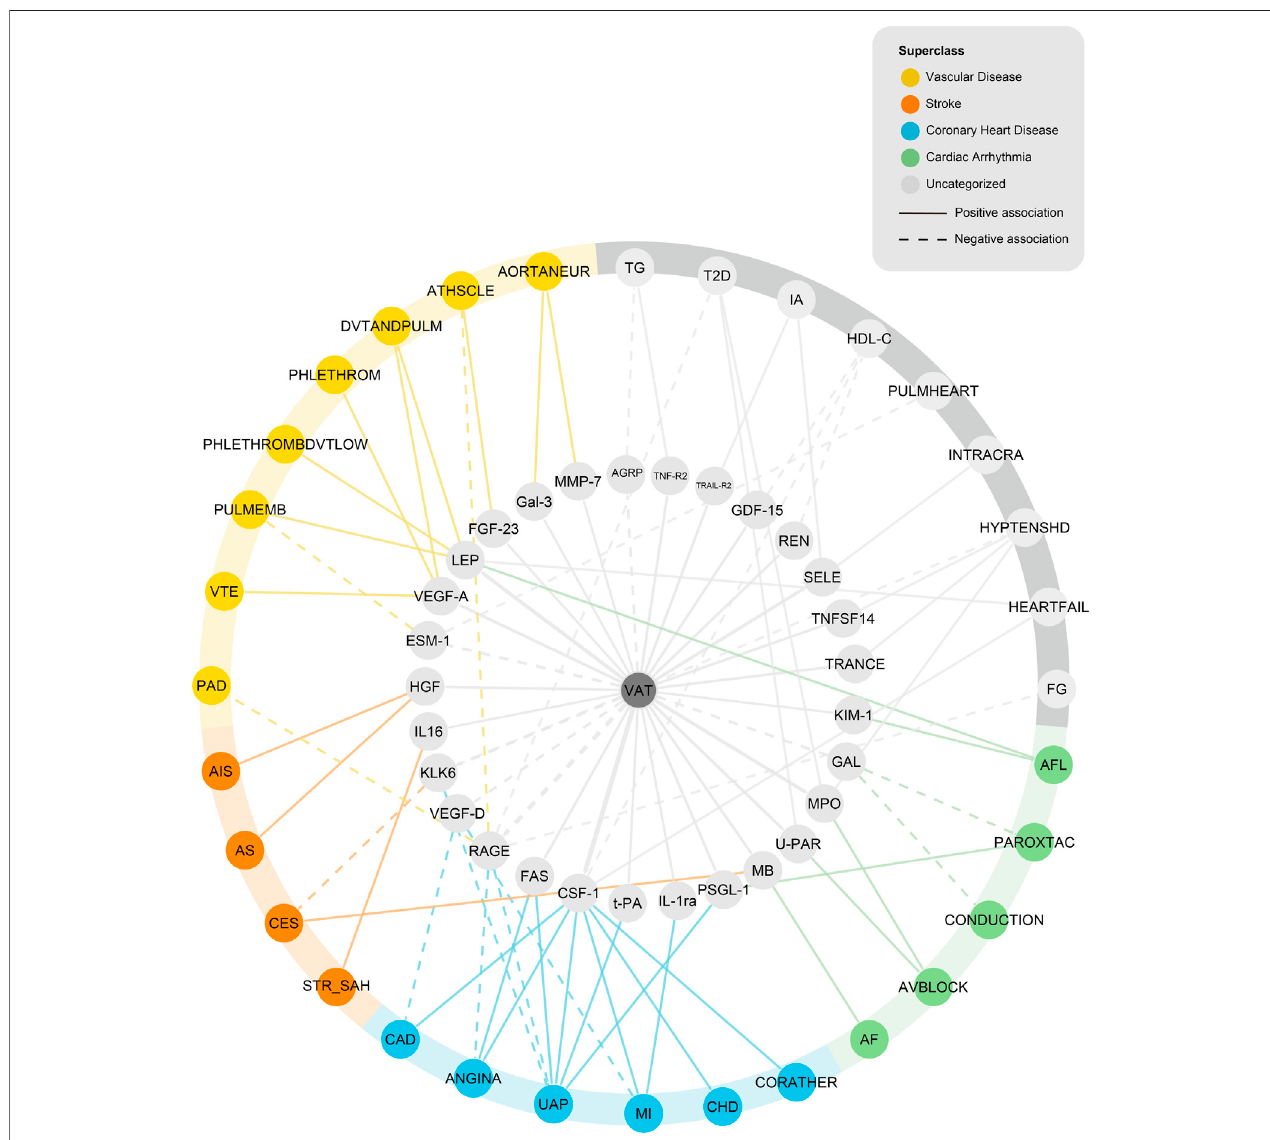
FIGURE4| NetworkanalysisofVAT-proteins-CVDs.AGRP,Agouti-relatedprotein;TNF-R2,Tumornecrosisfactorreceptor2;TRAIL-R2,TNF-relatedapoptosis- inducing ligand receptor 2; GDF-15, Growth/differentiation factor 15; REN, Renin; SELE, E-selectin; TNFSF14, Tumor necrosis factor ligand superfamily member 14; TRANCE, TNF-related activation-induced cytokine; KIM-1, Kidney injury molecule 1; GAL, Galanin peptides; MPO, Myeloperoxidase; U-PAR, Urokinase plasminogen activator surface receptor; MB, Myoglobin; PSGL-1, P-selectin glycoprotein ligand 1; IL-1ra, Interleukin-1 receptor antagonist protein; t-PA, Tissue-type plasminogen activator; CSF-1, Macrophage colony-stimulating factor 1; FAS, Tumor necrosis factor receptor superfamily member 6; RAGE, Receptor for advanced glycosylation end products; VEGF-D, Vascular endothelial growth factor D; KLK6, Kallikrein-6; IL16, Pro-interleukin-16; HGF, Hepatocyte growth factor; ESM-1, Endothelial cell-speci fi c molecule 1; VEGF-A, Vascular endothelial growth factor A; LEP, Leptin; FGF-23, Fibroblast growth factor 23; Gal-3, Galectin-3; MMP-7, Matrix metalloproteinase-7; TG, Triglycerides; T2D, Type 2 diabetes; IA, Intracranial aneurysm; HDL-C, High-density lipoprotein cholesterol; PULMHEART, Pulmonary heart disease, diseases of pulmonary circulation; INTRACRA, Nontraumatic intracranial haemmorrhage; HYPTENSHD, Hypertensive Heart Disease; HEARTFAIL, All-cause Heart Failure; FG, fasting glucose; AFL, atrial fi brillation and fl utter; PAROXTAC, Paroxysmal tachycardia; CONDUCTION, Conduction disorders; AVBLOCK, AV-block; AF, Atrial fi brillation; CORATHER, Coronary atherosclerosis; CHD, Major coronary heart disease event; MI, myocardial infarction; UAP, Unstable angina pectoris; ANGINA, Angina pectoris; CAD, coronary artery disease; STR_SAH, Stroke, including SAH; CES, Cardioembolic stroke; AS, Any stroke; AIS, Ischemic stroke; PAD, Peripheral artery disease; VTE, Venous thromboembolism; PULMEMB, Pulmonary embolism; PHLETHROMBDVTLOW, DVT of lower extremities; PHLETHROM, Phlebitis and thrombophlebitis (not including DVT); DVTANDPULM, DVT of lower extremities and pulmonary embolism; ATHSCLE, Atherosclerosis, excluding cerebral, coronary and PAD; AORTANEUR, Aortic aneurysm.